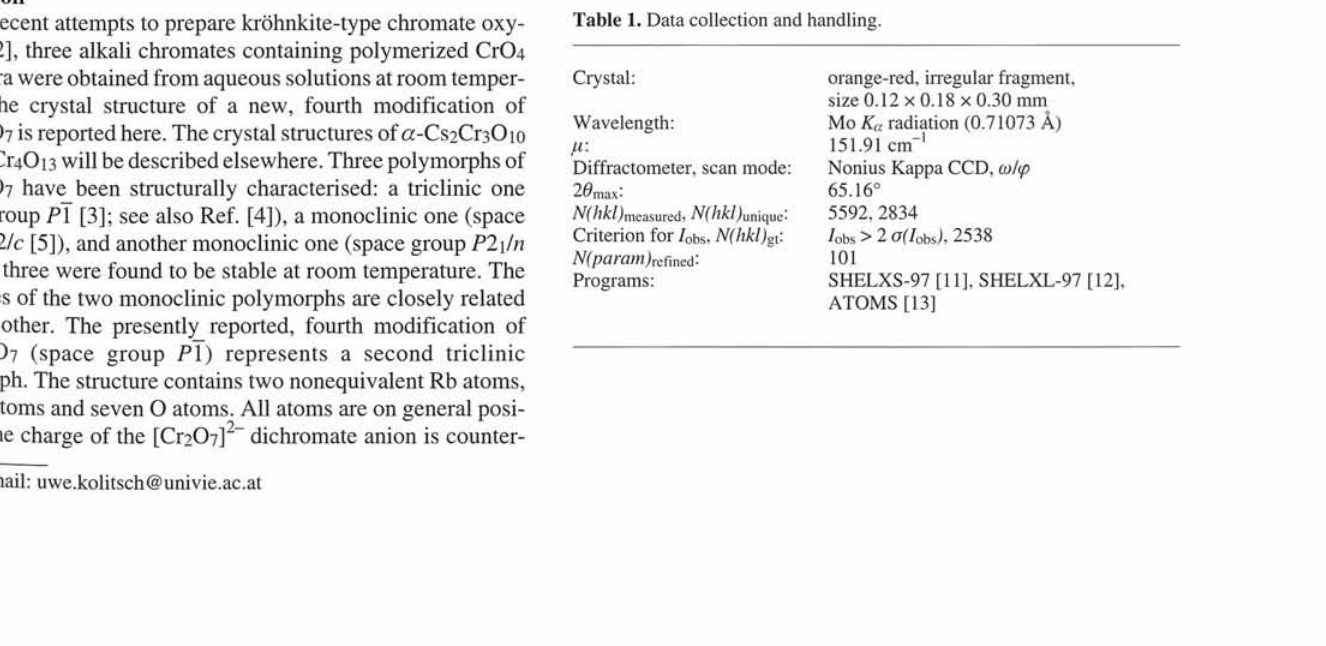
Table 1. Data collection and